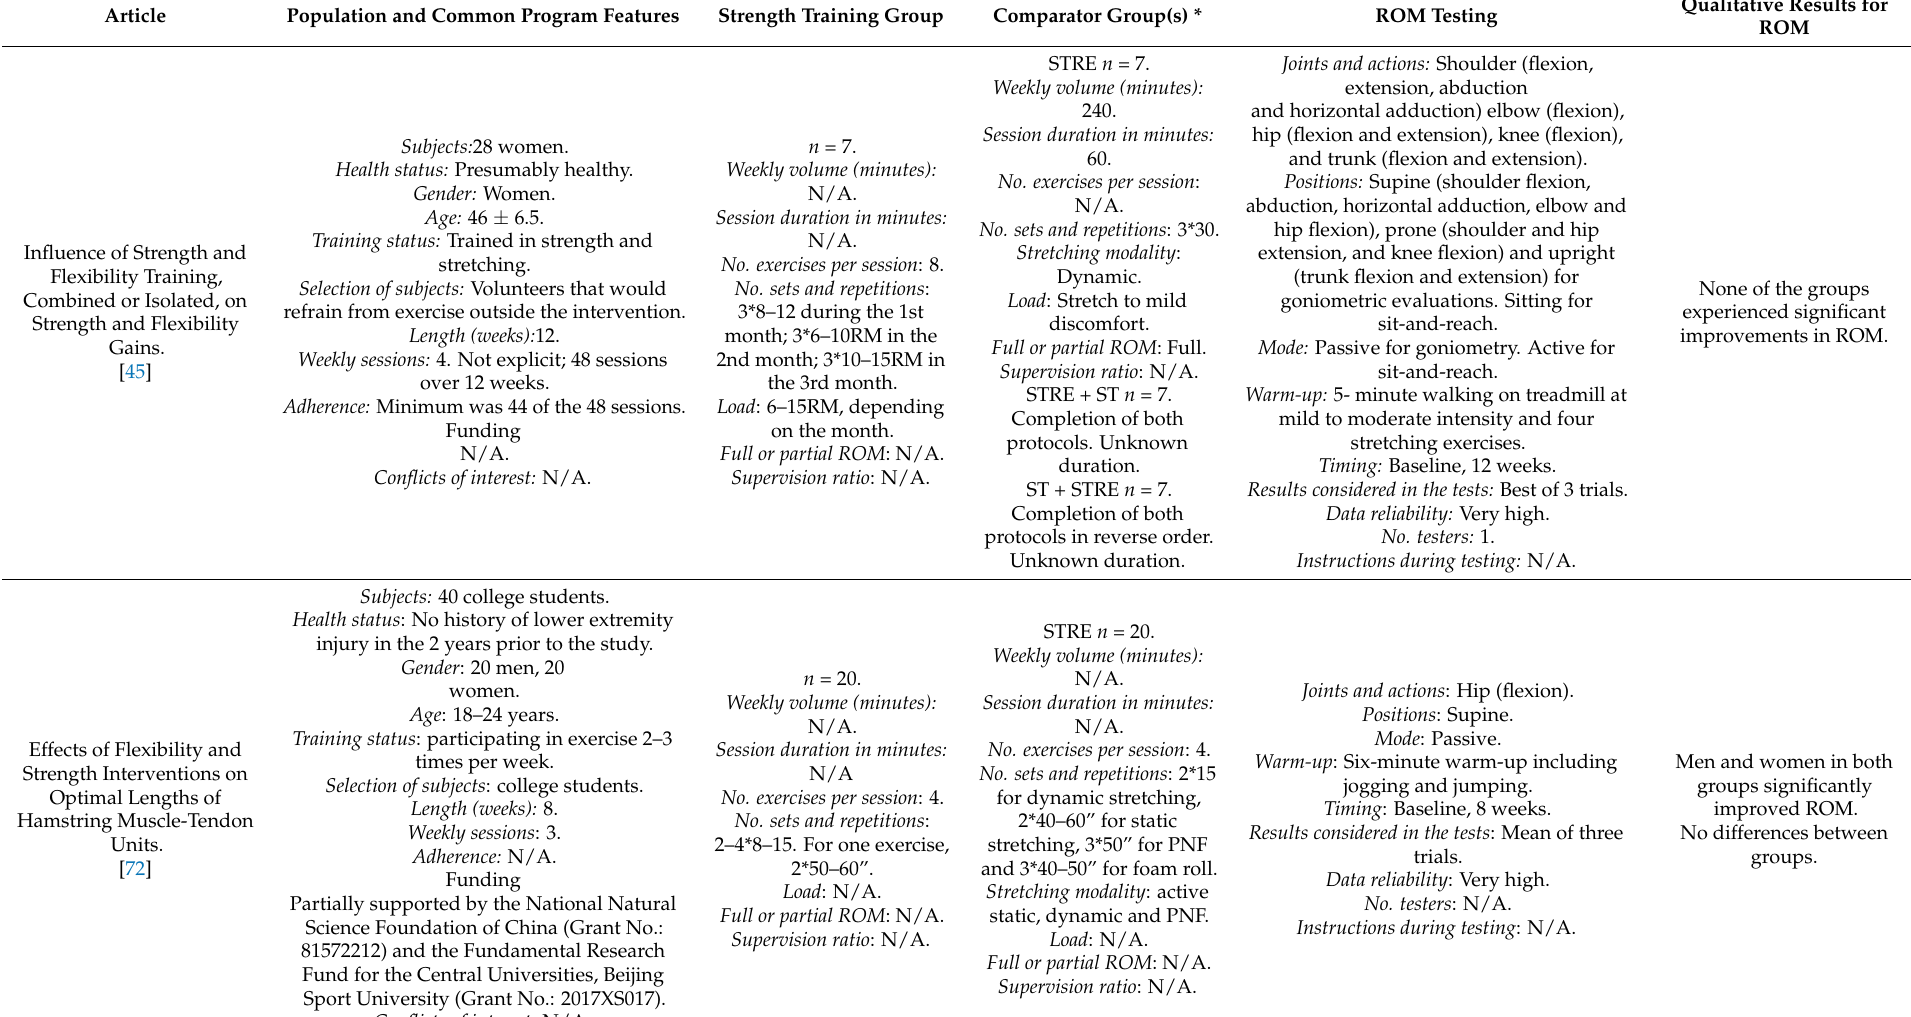
Strength Training Group Comparator Group(s) * ROM Testing